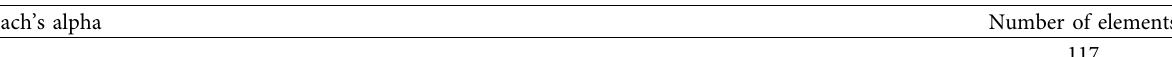
Table 3: Reliability statistics.